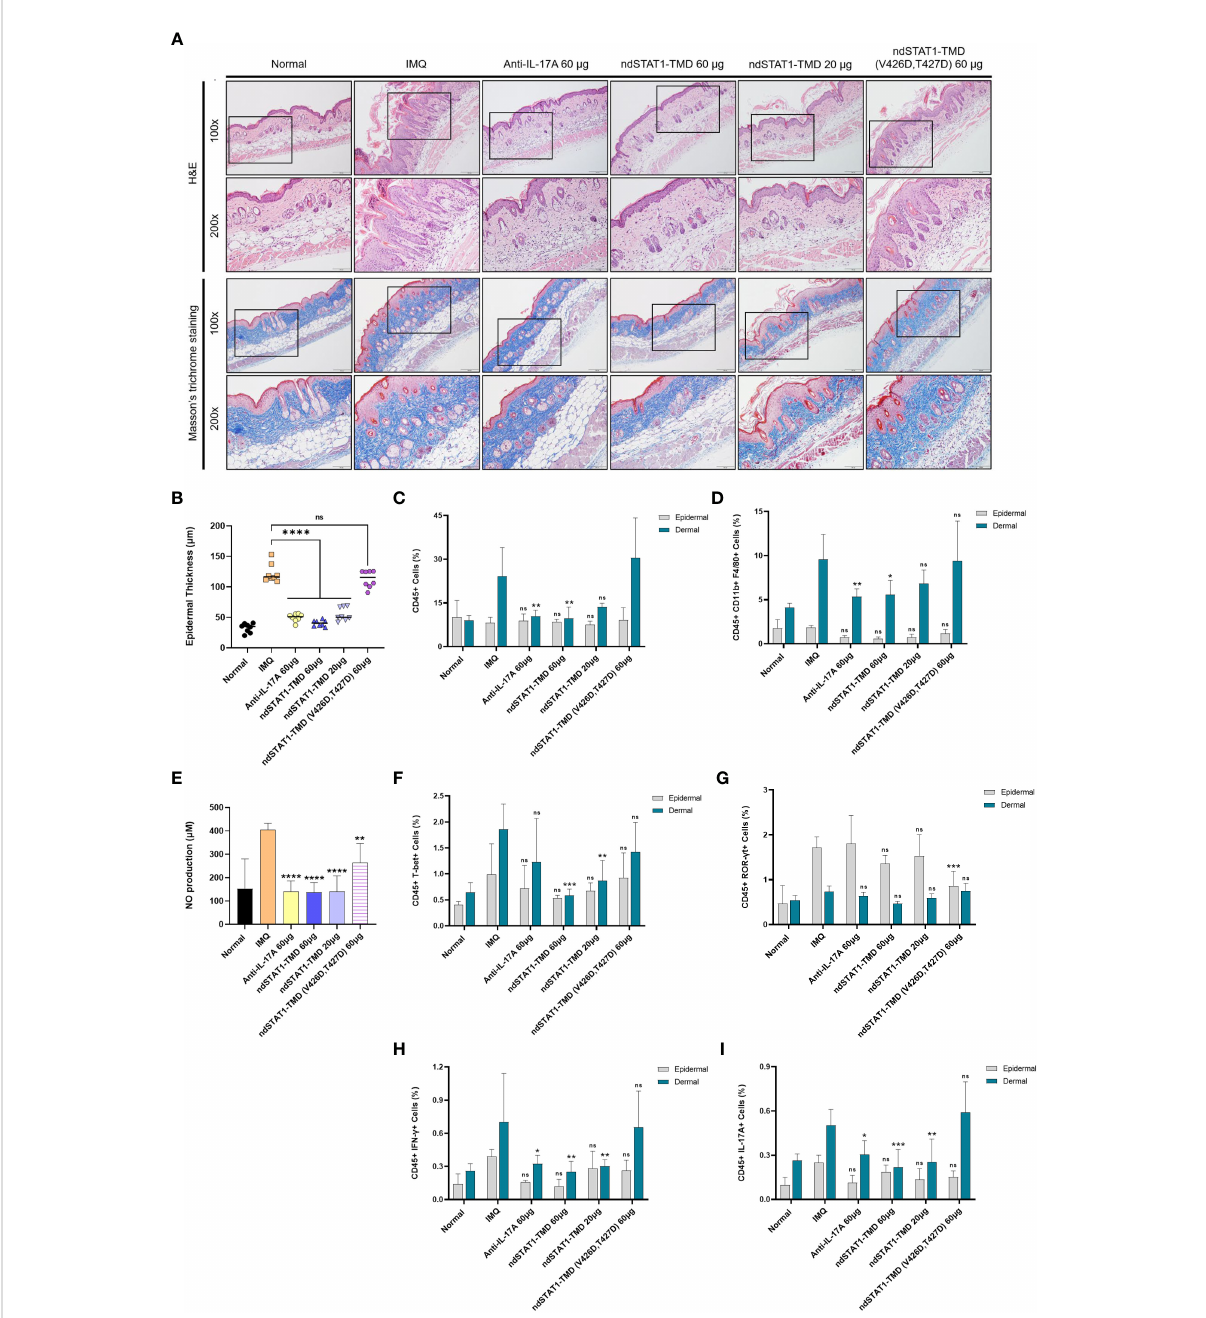
FIGURE 6 ndSTAT1-TMD treatment of psoriasis animal model prevents the in fi ltration of leukocytes into the back skin. (A) Representative H&E staining (above panel) or Masson ’ s trichrome staining (below panel) of mice back skin in each group on day 7. Scale bar represents 200 m m for 100X and 100 m m for 200X. (B) Change in the epidermal thickness of mice ’ s back skin of each treated group was measured by the histological images from (A) . The graph is represented as mean ± SEM (n=8), and the statistical analysis was examined using Student ’ s t-test. ns, not signi fi cant, and ****p<0.0001. (C) The level of in fi ltrating CD45 + leukocytes in the dorsal epidermis (grey) or dermis (blue) area in each group on day 7. (D) The level of in fi ltrating macrophages expressing CD45, CD11b, and F4/80 in the dorsal epidermis (grey) or dermis (blue) area of each group on day 7. (E) The nitric oxide (NO) level in the serum of mice in each treated group on day 7. (F, G) The level of in fi ltrating T-bet + (F) or ROR- g t + (G) T cells in the whole CD45 + leukocytes in the dorsal epidermis (grey) or dermis (blue) area of each treated group on day 7. (H, I) The level of in fi ltrating IFN- g + (H) or IL-17A + (I) T cells in the whole CD45 + leukocytes in the dorsal epidermis (grey) or dermis (blue) area of each treated group on day 7. The graphs in (C-I) are represented as mean ± SEM (n=6). The statistical analysis was examined using Student ’ s t-test, and statistical signi fi cance was indicated when the percentage of the cell population was lower than the IMQ group. ns, not signi fi cant, *p<0.05, **p<0.01, and